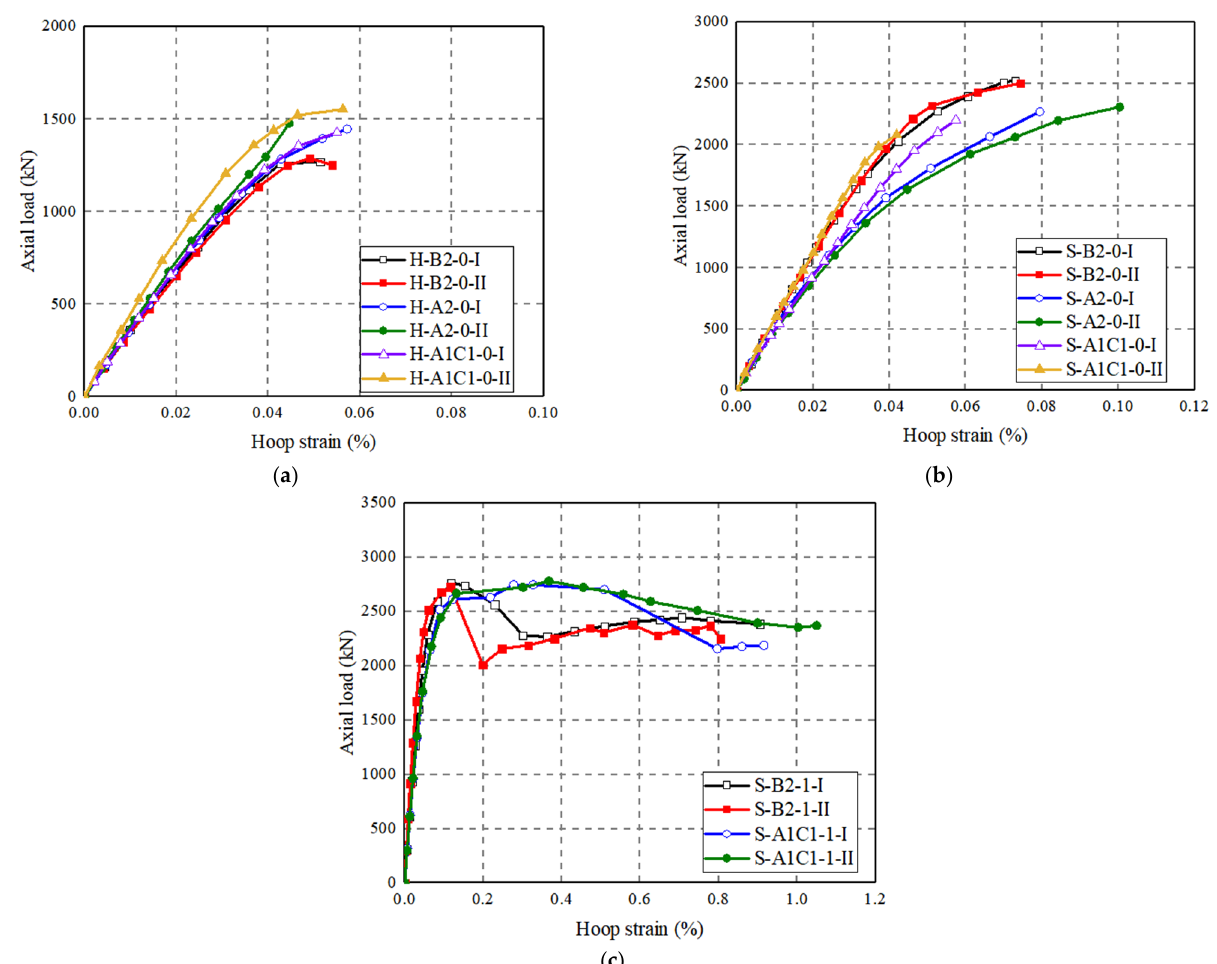
Figure 14. Effect of FRP grid positioning on axial load–hoop strain curves of the specimens. ( a ) FRP grid-UHPC tubular columns; ( b ) Concrete-filled FRP-grid UHPC tube columns; ( c ) CFRP-confined concrete-filled FRP grid-UHPC tube columns.